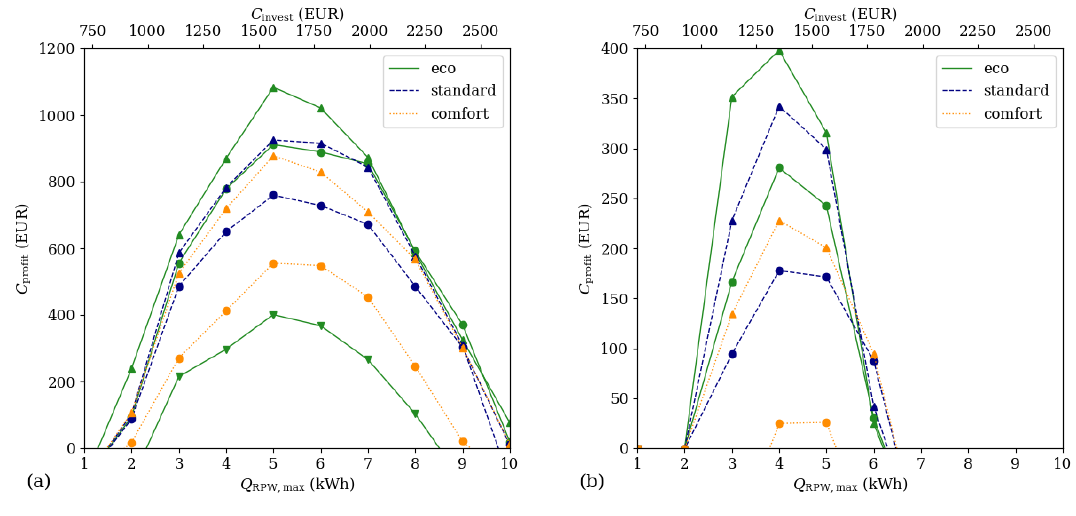
Figure 4. Profit after 20 years of operation for ( a ) Case #1 (passive house located in Helsinki) and ( b ) Case #2 (low energy building located in Strasbourg). Markers “ ▼ ”, “●” and “ ▲ ” denote small (140 L), medium (210 L) and large (280 L) decentralized DHW storage devices. Please note that for some